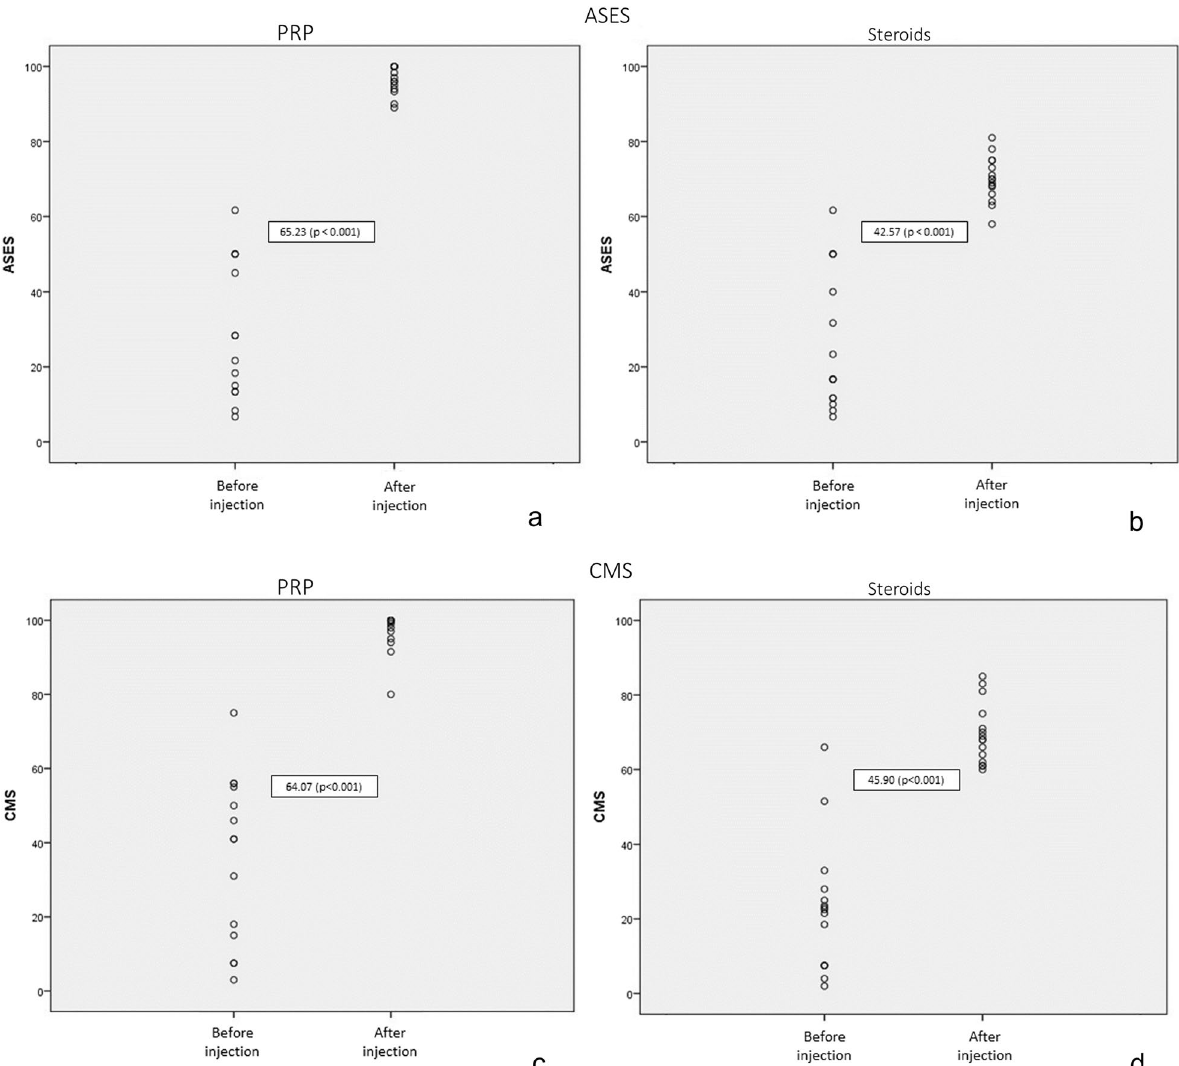
Fig. 4 ASES comparison before and 6 months after injection of PRP ( a ) and steroids ( b ). CMS comparison before and 6 months after injection of PRP ( a ) and steroids ( b ). ASES, American Shoulder and Elbow Surgeons Shoulder score; CMS, Constant–Murley